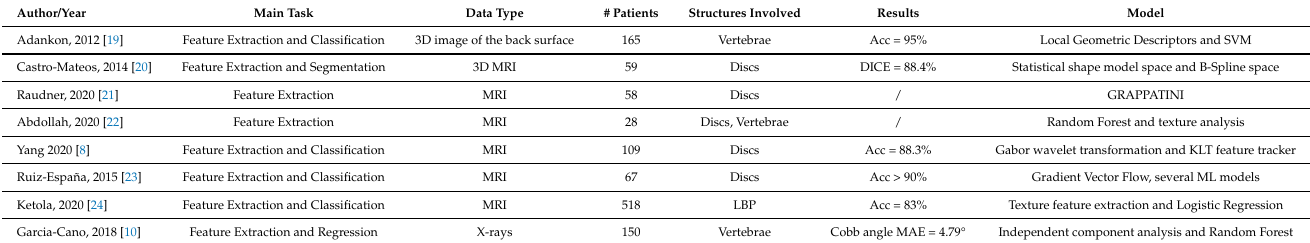
Table 1. Feature extraction. For each work, it is reported whether or not other tasks are performed following feature extraction. The reported results are related to the task following feature extraction. Abbreviations are used for Magnetic Resonance Imaging (MRI), Low Back Pain (LBP), Accuracy (Acc), Mean Absolute Error (MAE), Machine Learning (ML), Support Vector Machine